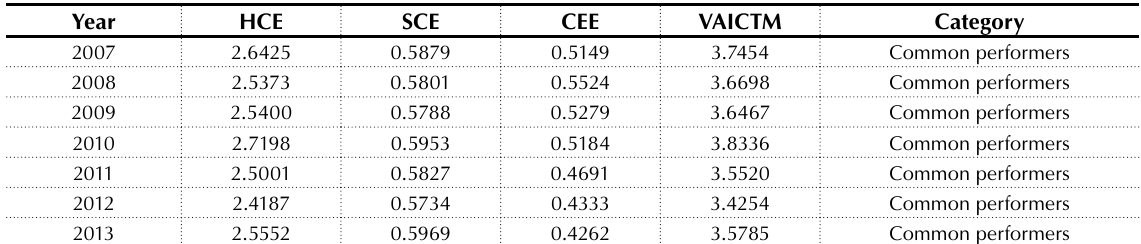
Source: The data processed.